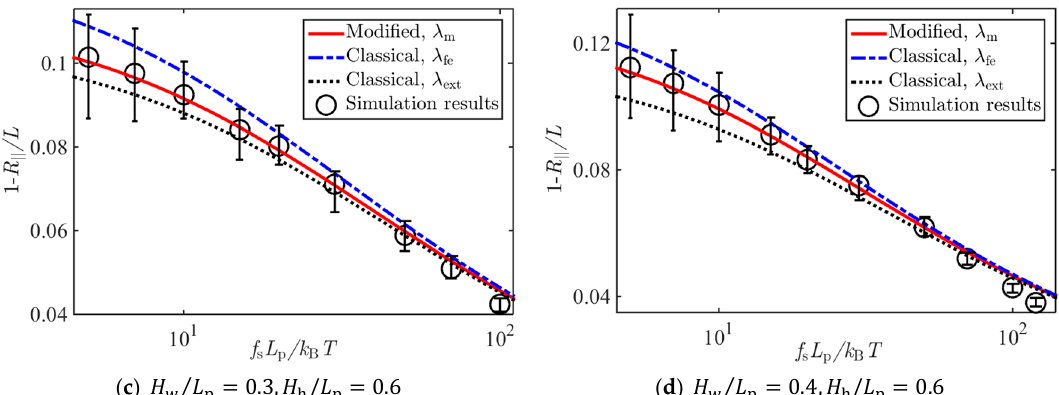
Figure 6. Comparison of Brownian dynamics simulations and theoretical predictions on the relative average extension of a WLC under stretching forces and confinements of rectangular tubes with sizes ( a ) H w / L p = 0.2, H h / L p = 0.3, ( b ) H w / L p = 0.3, H h / L p = 0.4, ( c ) H w / L p = 0.3, H h / L p = 0.6, and ( d ) H w / L p = 0.4, H h / L p = 0.6.